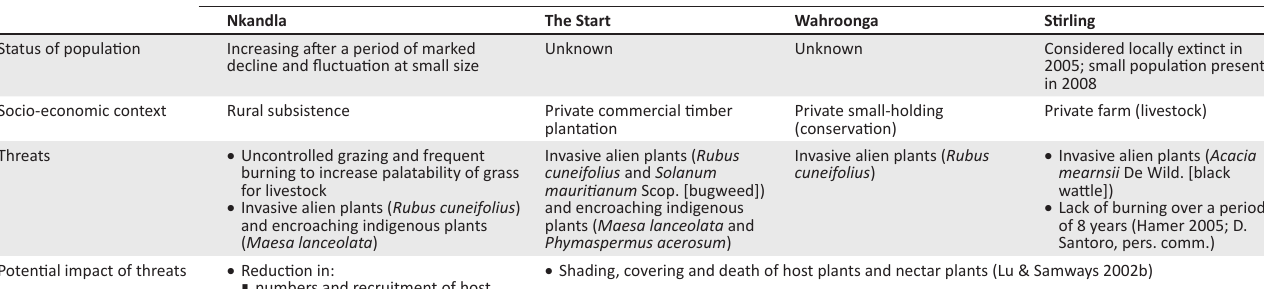
TABLE 1: Characteristics of, and factors relating to, the known Orachrysops ariadne colonies and colony sites. Characteristic or